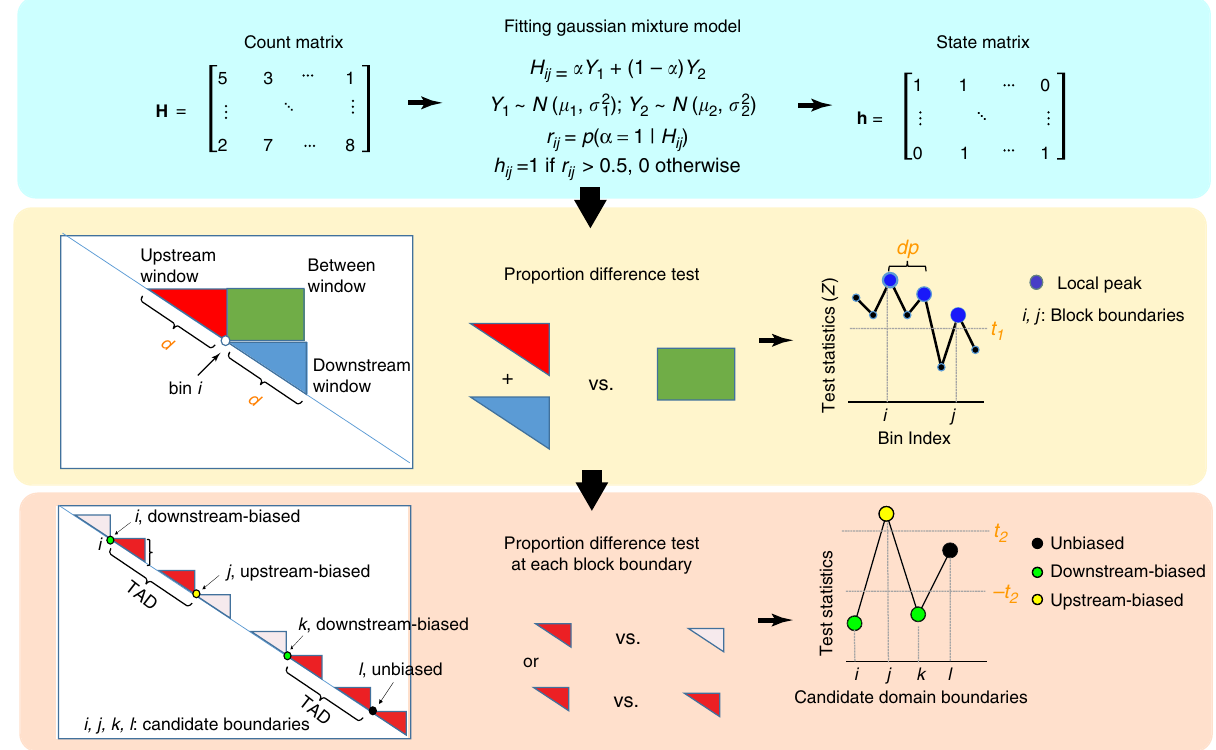
Fig. 1 Overview of the GMAP method. The method consists of three major steps. In step one, we fi t a Gaussian mixture model with two components representing chromatin interactions within and outside of a domain. In step two, for each genomic bin, we determine if it is located at the boundary of blocks of dense chromatin interactions by performing a proportion test of observed contact counts within and between windows fl anking the bin. In step three, we call chromatin domains based on the location and orientation of the candidate boundaries identi fi ed in step